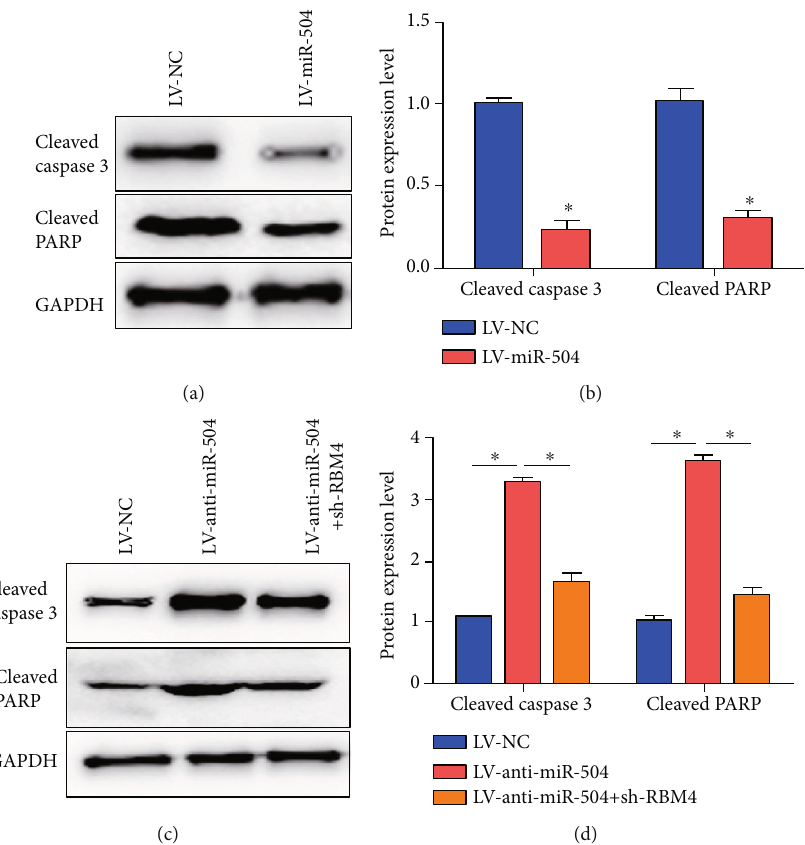
Figure 5: miR-504 suppressed SGC-7901 cell apoptosis via targeting RBM4. (a, b) Relative protein expression of cleaved caspase 3 and cleaved PARP in the LV-NC group and LV-miR-504 group. (c, d) Relative protein expression of cleaved caspase 3 and cleaved PARP in each group. ∗ P < 0 : 05